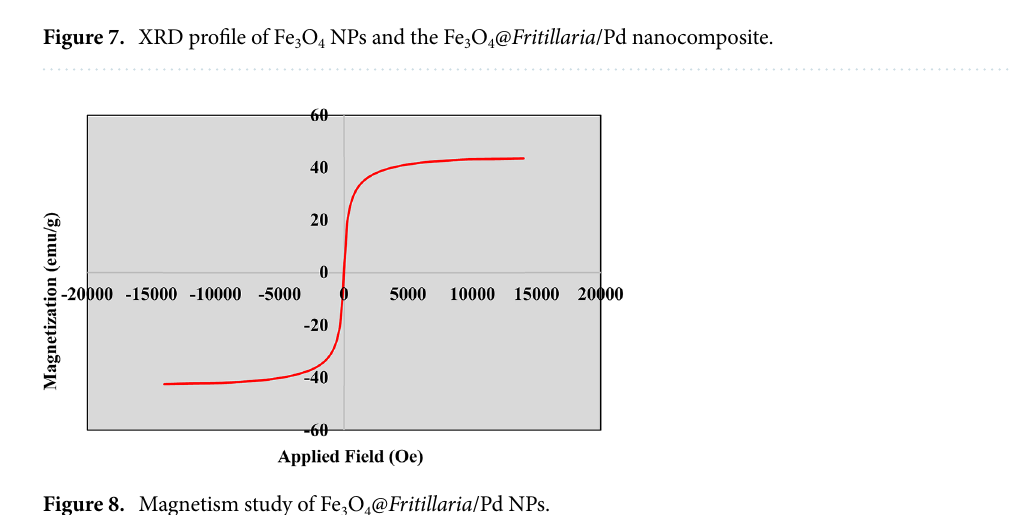
Figure 8. Magnetism study of Fe 3 O 4 @ Fritillaria /Pd